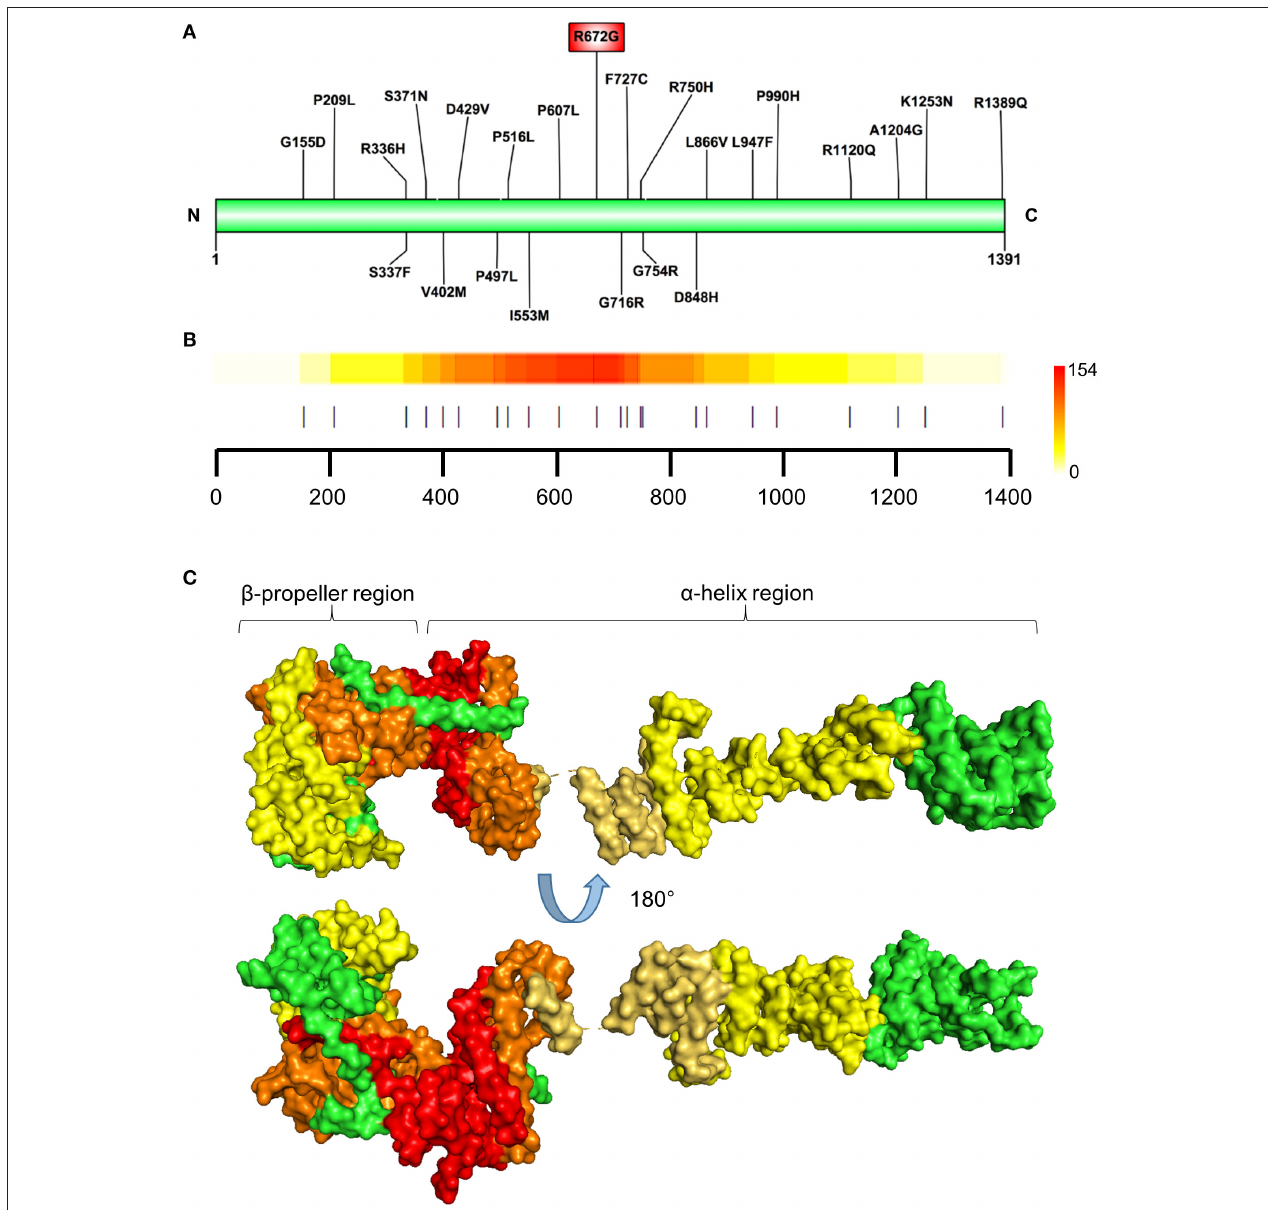
FIGURE 3 | Identification of prioritized variant hostpot. (A) Schematic illustration showing locations of the NUP155 prioritized variants. Highest prioritized variant identified in the present analysis (R672G) indicated in the red rectangle. (B) Variant cluster analysis defines a hotspot within the NUP155 protein. Localization of all variants predicted to be highly pathogenic depicted. Colorscale to the right indicates low-to-high range clustering enrichment scores (0–154). Red indicates high clustering regions. Horizontal axis provides amino acid position as shown in (A) with each prioritized variant indicated by a vertical line. (C) Surface rendering of a predicted 3D model of NUP155 reveals enrichment of the cardiopathogenic cluster in the crescent-shaped N-terminal domain of the protein. Top and bottom illustrations show alternate rotated views to highlight distribution of low and high clustered regions. Green, NUP155; yellow, low clustering; orange, midrange; red,